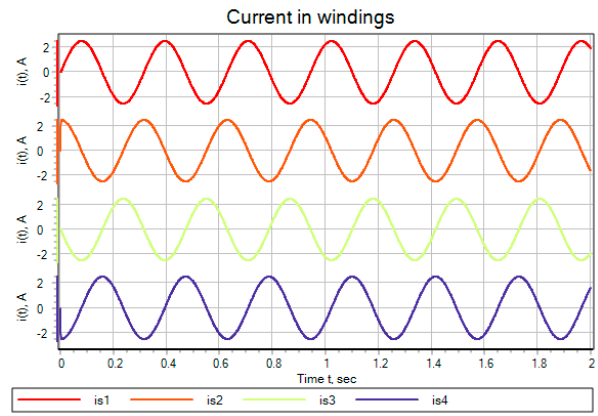
Figure 14. Current flowing in the stator windings.